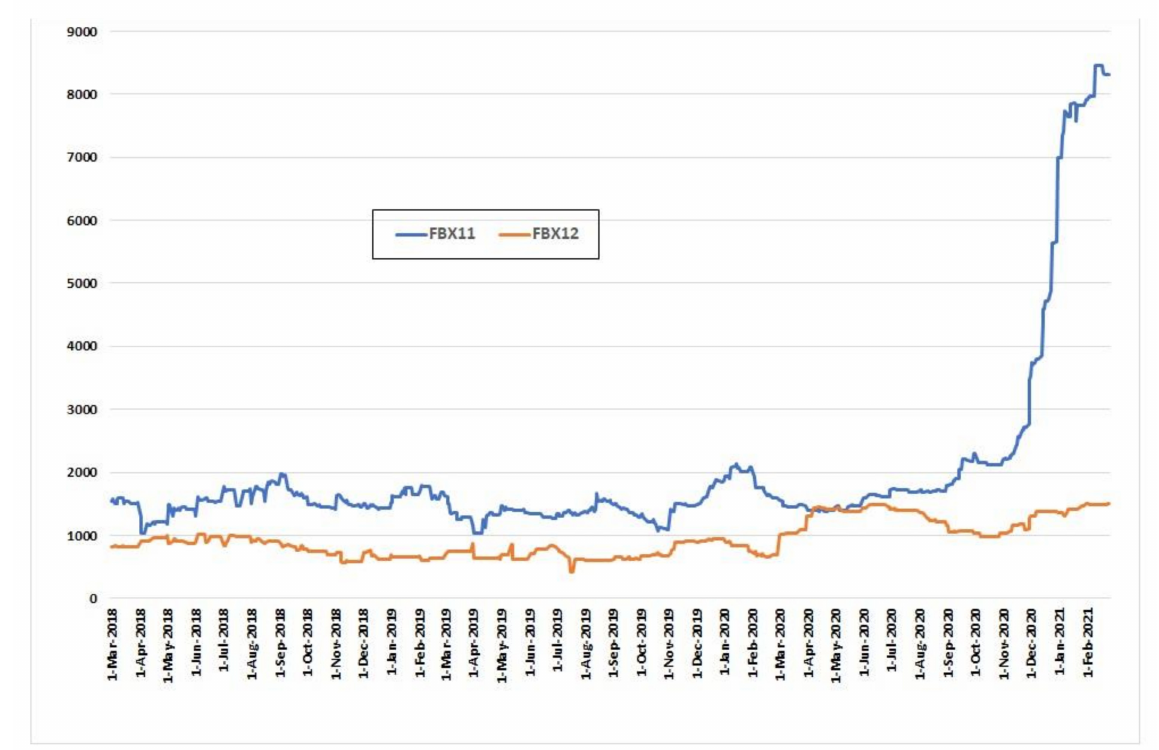
Figure 6. FBX 11 and FBX 12 freight rates for three years (from 1 March 2018 to 26 February 2021).